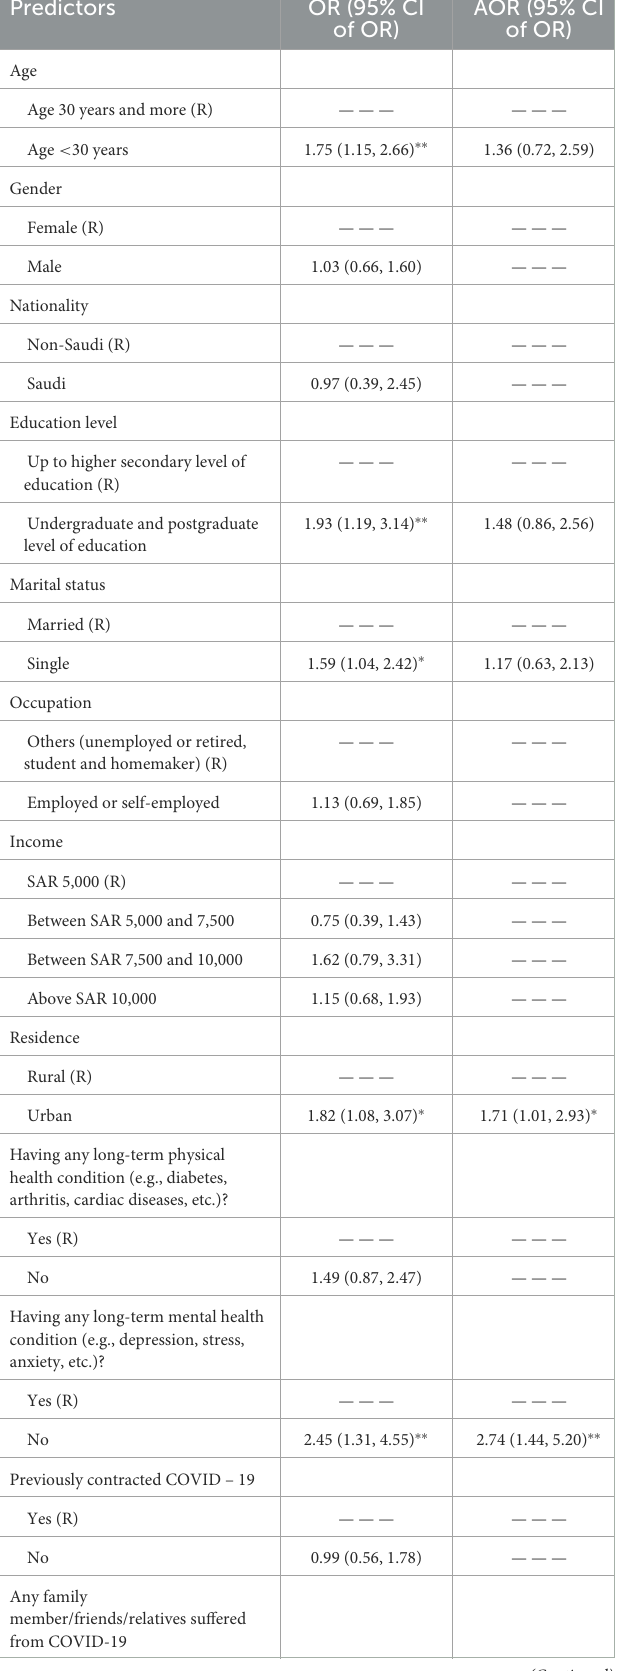
TABLE 6 Determinants of good knowledge of COVID-19 disease.